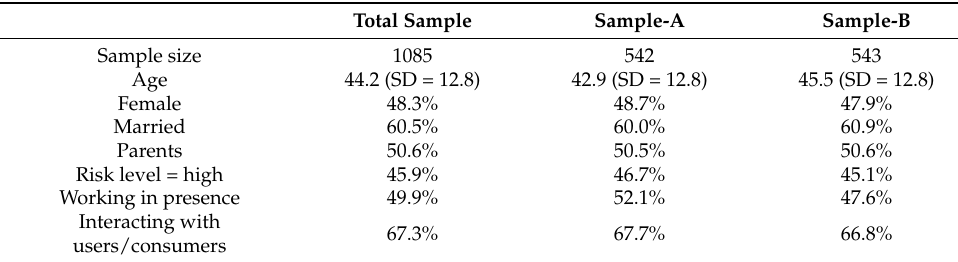
Table 2. Description of samples using dichotomous